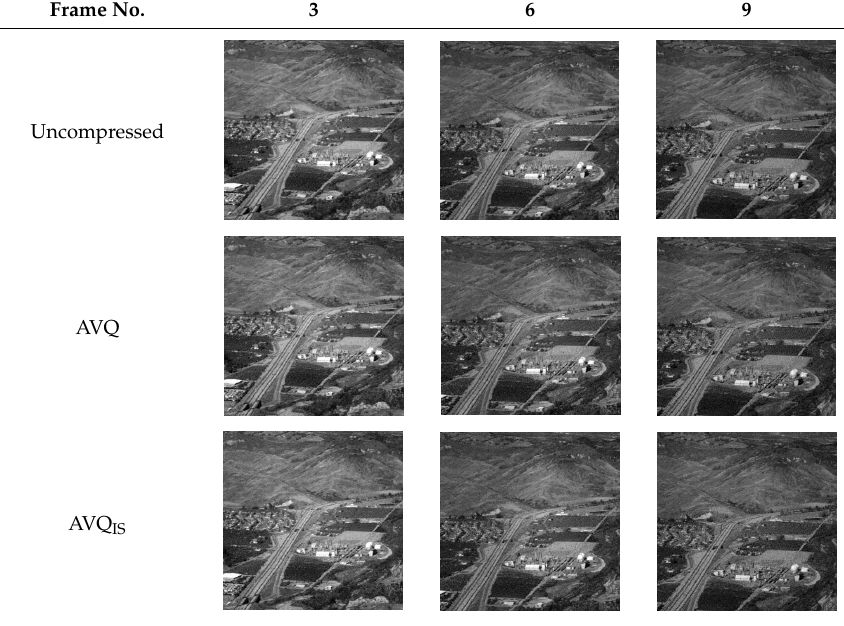
Table A3. Example of some frames from Seq. 3-Dataset 1. Frame No.